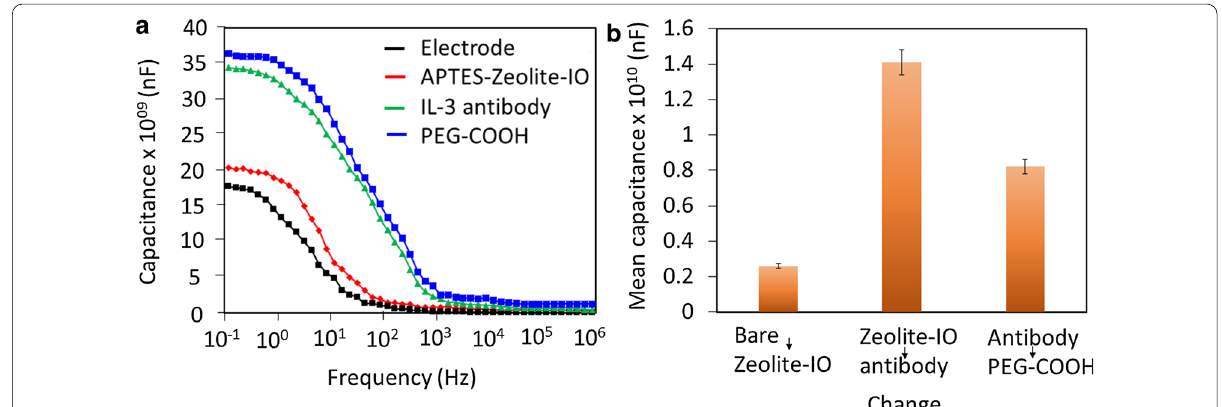
Fig. 3 a Process of antibody attachment to the zeolite-iron-modified surface. capacitance values increased after each molecular immobilization. b Difference in capacitance. Anti-IL-3 antibody immobilization showed a higher change in the capacitance value. The values were averaged using